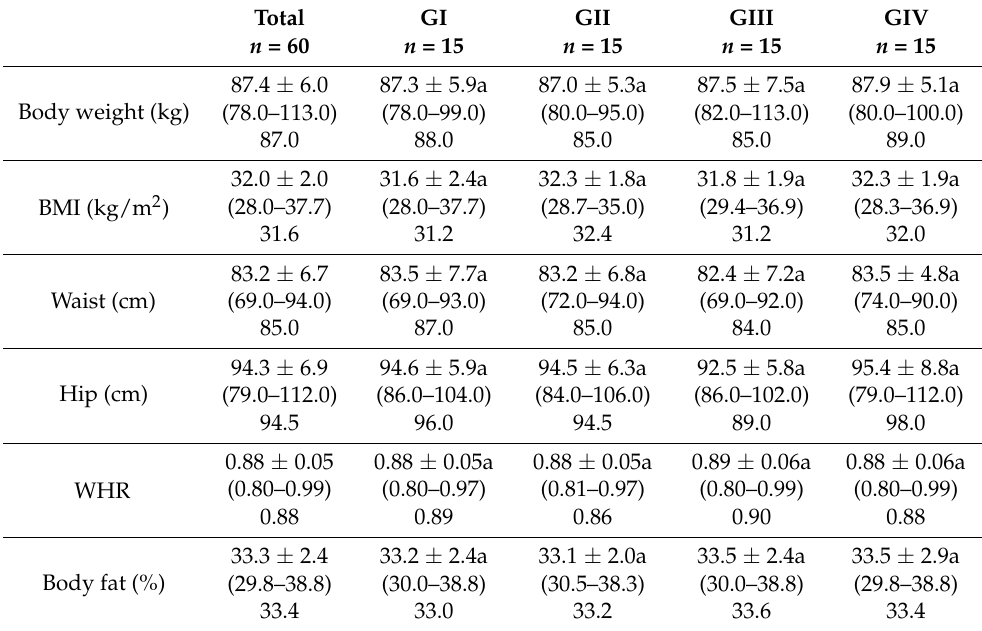
Table 1. The anthropometric parameters of subjects at the beginning of the study.